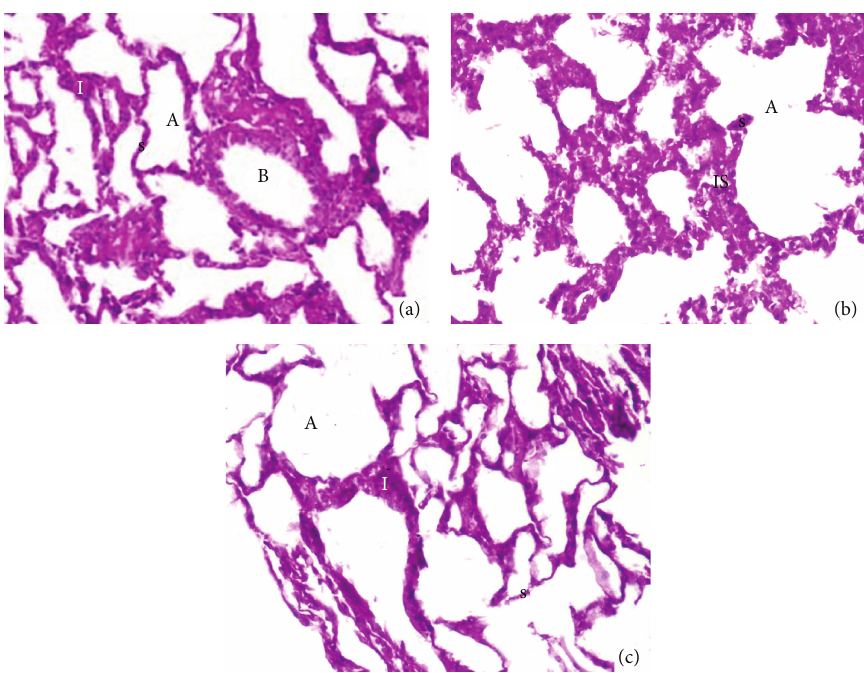
Figure 4: (a) A photomicrograph of transverse section in the control rat lung shows positive PAS staining with normal architecture of alveoli (A) with thin interalveolar septa (s) and normal interstitial tissues (I) (PAS × 400). (b) A photomicrograph of transverse section in the second group rat lung shows moderate positive PAS staining with nearly normal architecture of alveoli (A), thick interalveolar septa (s), and interstitial tissues (I) (PAS × 400). (c) A photomicrograph of transverse section of third group rat lung shows negative PAS staining, accumulation of inflammatory cells near the blood vessels with abnormal architecture of alveoli (A), and destruction of the interalveolar septa (s) and interstitial tissues (I) (PAS ×